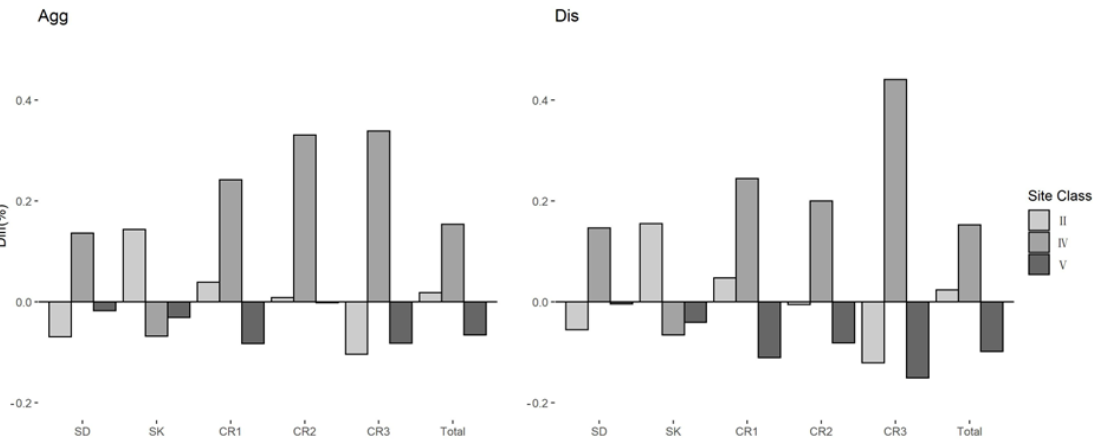
Figure 2. Fitted curves of two prediction models for the biomasses of each component and total biomass at different site classes.